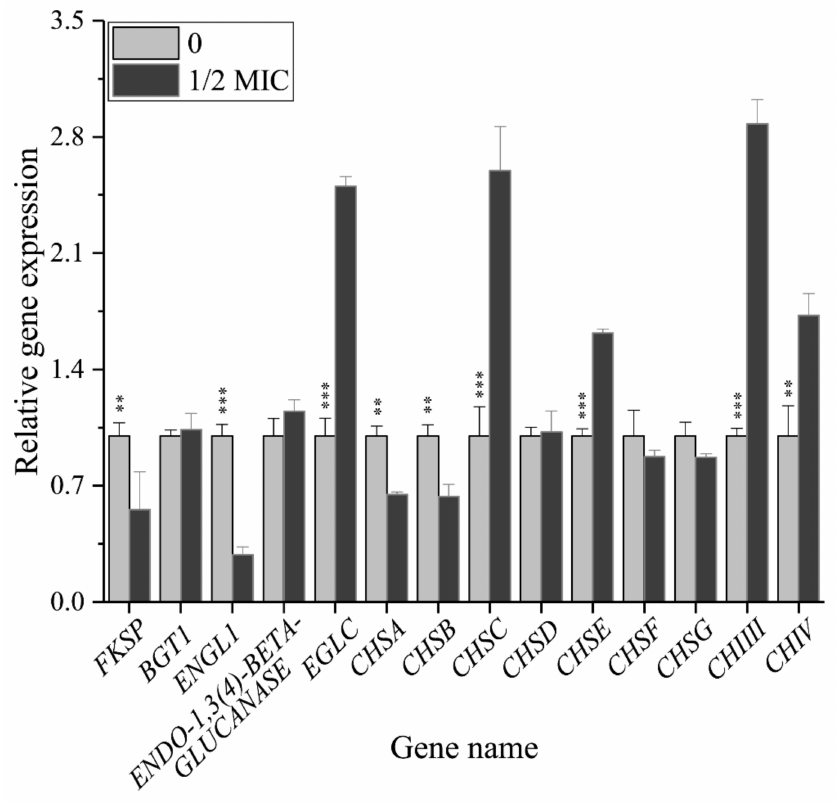
Figure 6. Relative gene expression of A. flavus treated with paeonol at 0 and 1/2 MIC. Student’s t -test, **: p < 0.01, ***: p <